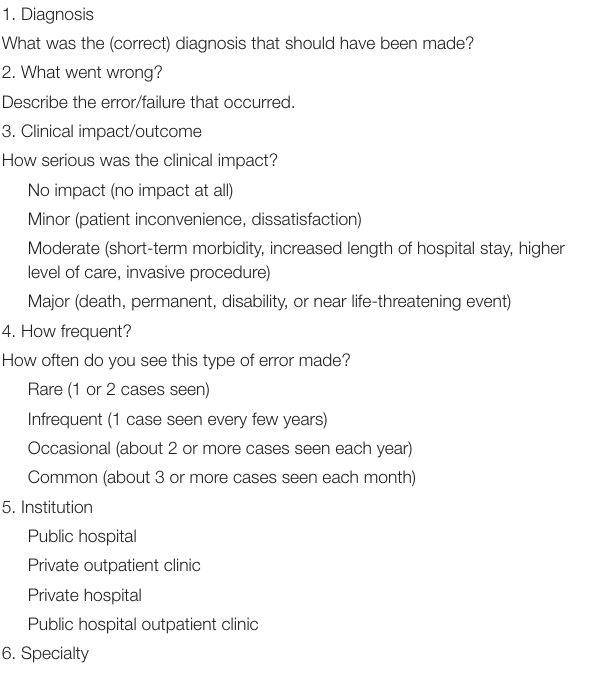
TABLE 1 | Six-item